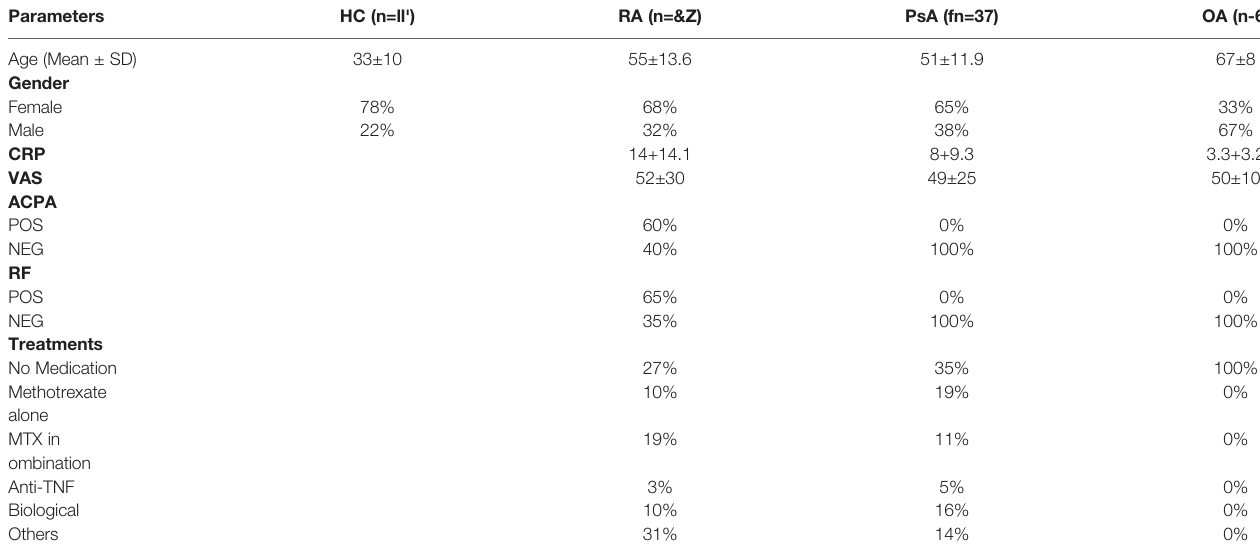
TABLE 1 | Patients ’ demographic. Age, Gender, CRP, VAS, serology and detail on treatment. Healthy control (HC) demographic, age and gender.